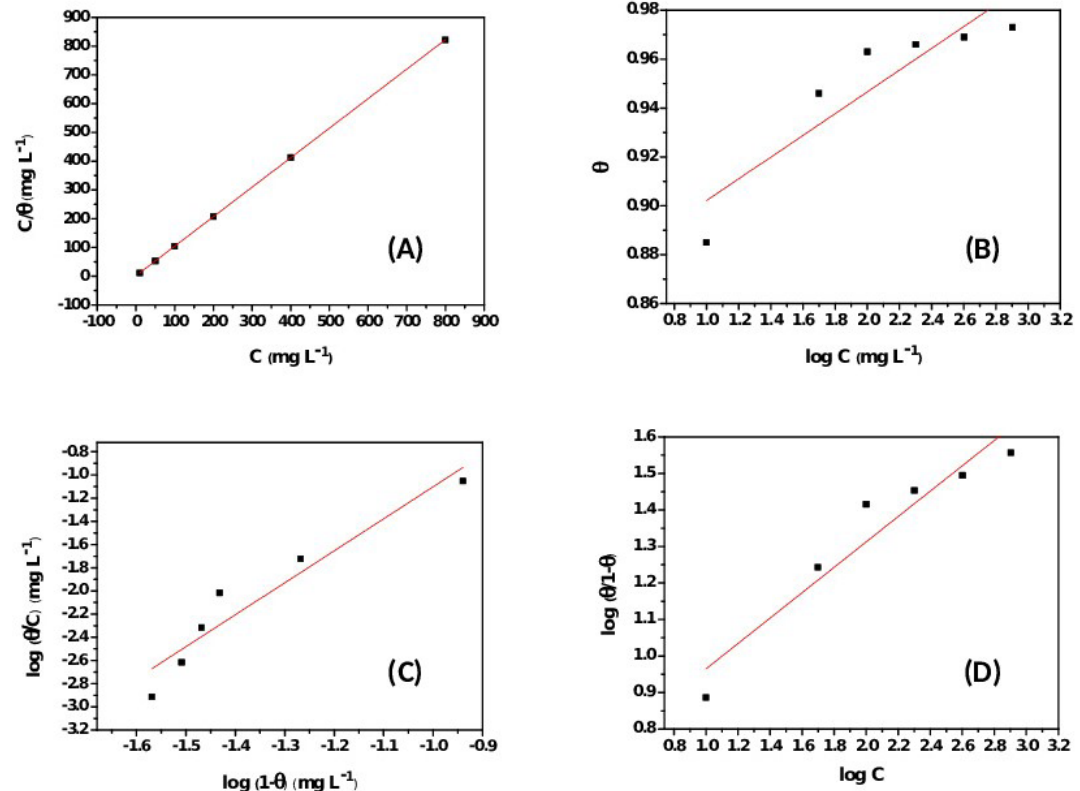
Figure 6. Adsorption isothermsof (A) Langmuir, (B) Temkin, (C) Flory-Huggins and (D) El-Awady for ACSEon the mild steel surface in 1 mol L −1 HCl solution.